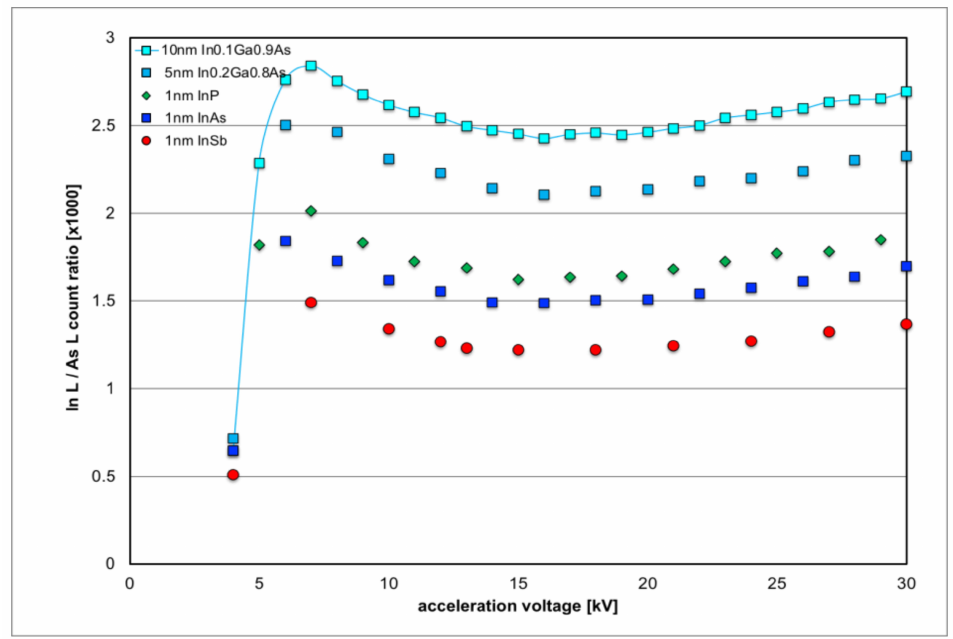
Figure 4. Monte Carlo simulation of the intensity ratio of In L/As L X-ray lines for various In- containing thin layers on GaAs as function of electron acceleration